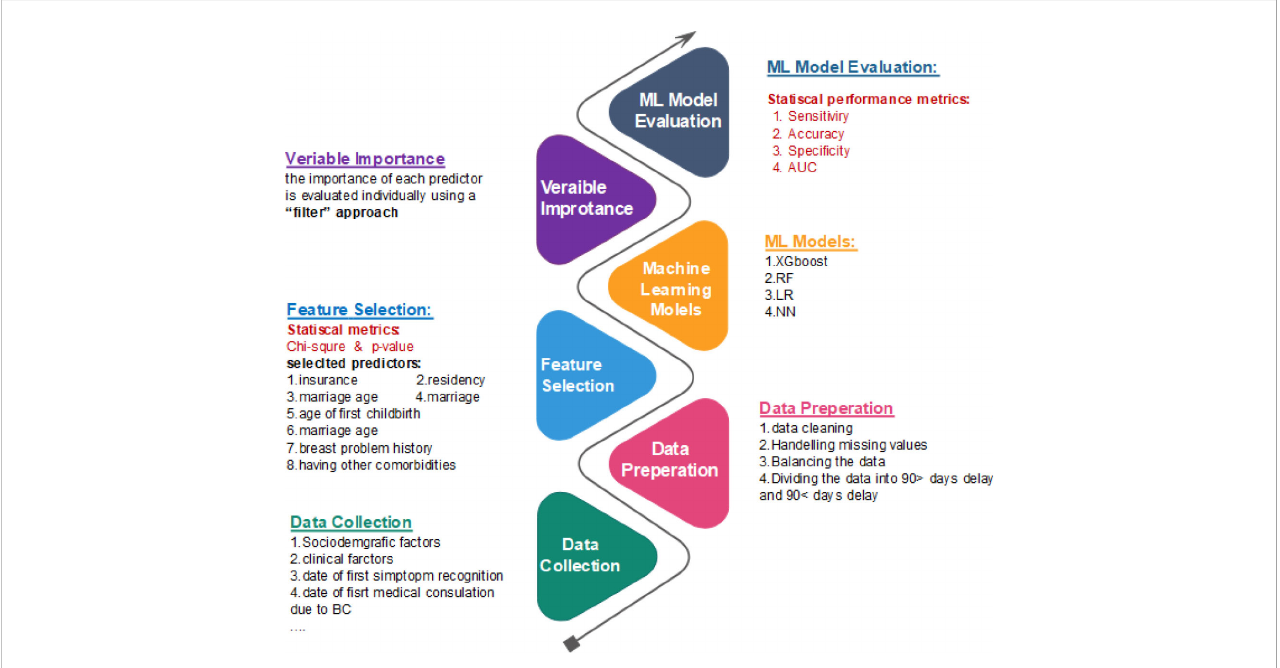
FIGURE 1 Steps for building the prediction model and the statistical methods used in each